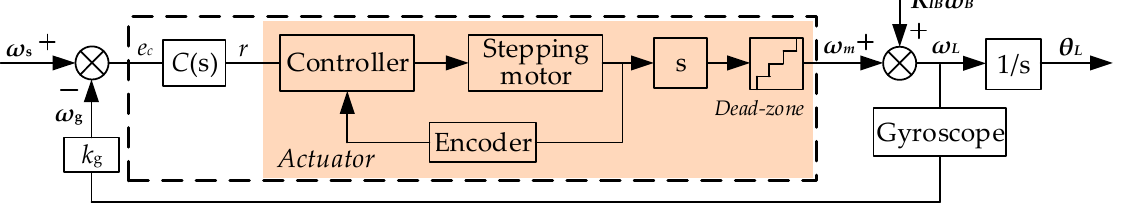
Figure 4. Typical inertial stabilized control by the angular velocity loop.